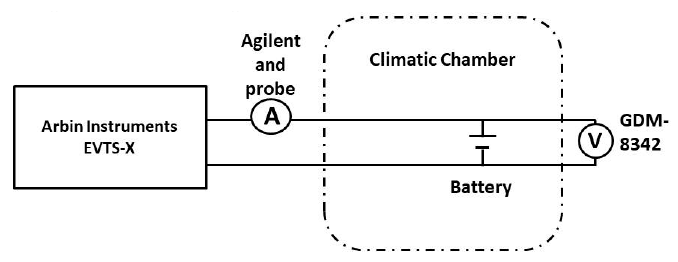
Figure 5. Schematic of the experimental set-up. Table 1. Instrumentation used in the experimental set-up.